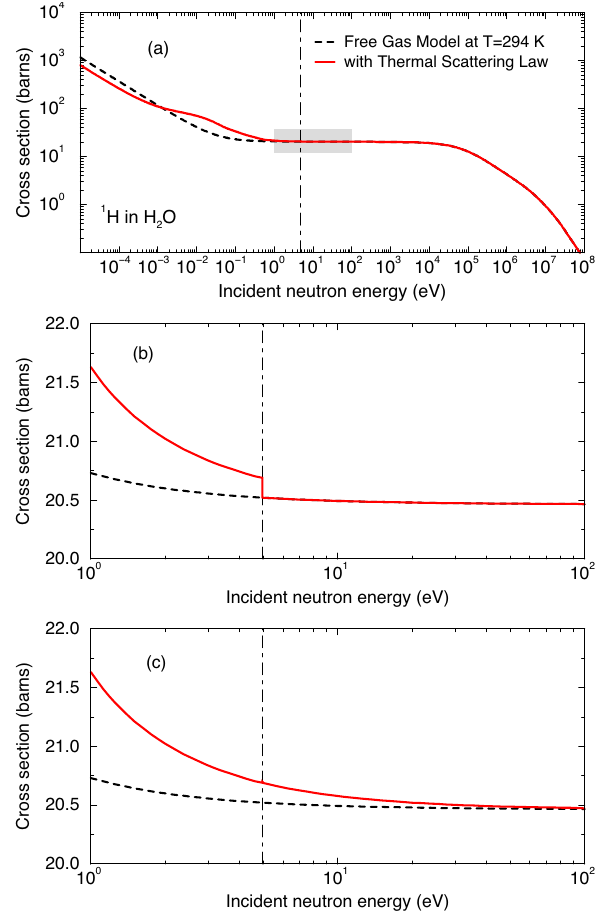
Fig. 1. Elastic scattering cross section of 1 H in H 2 O as a func- tion of the neutron incident energy. The top plot (a) shows the neutron cross-section over the full energy range. The mid- dle plot (b) highlights the discontinuity at the thermal cut-off energy (4.95 eV) between the thermal scattering law and the Free Gas Model when the thermodynamic temperature T is introduced in the Free Gas Model. The bottom plot (c) shows the continuous behaviour of the cross-section when T = T eff